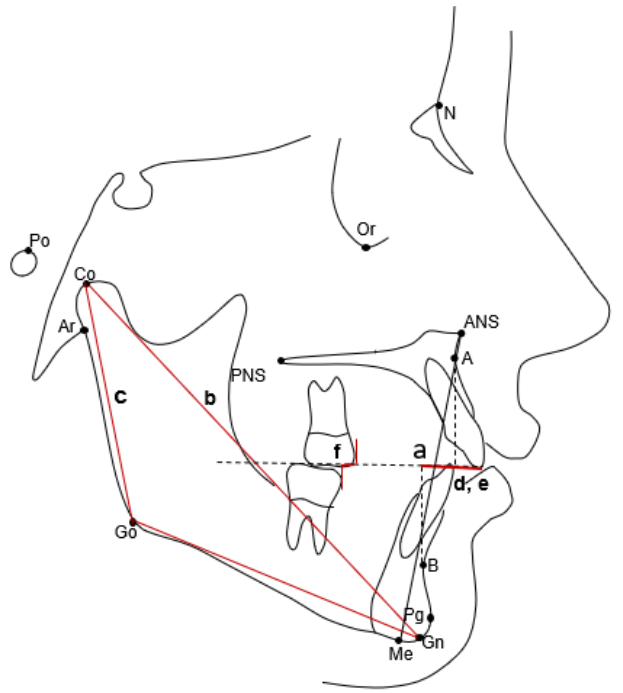
Figure 3. Cephalometric landmarks and linear measurements. Cephalometric landmarks: A, A point; B, B point; Gn, Gnathion; Me, Menton; Go, Gonion; Co, Condylion. Cephalometric linear measurements: (a) Wits appraisal; (b) Co-Gn total mandibular length; (c) Co-Go ramus height; (d) OVJ overjet; (e) OB overbite; (f) molar relationship.